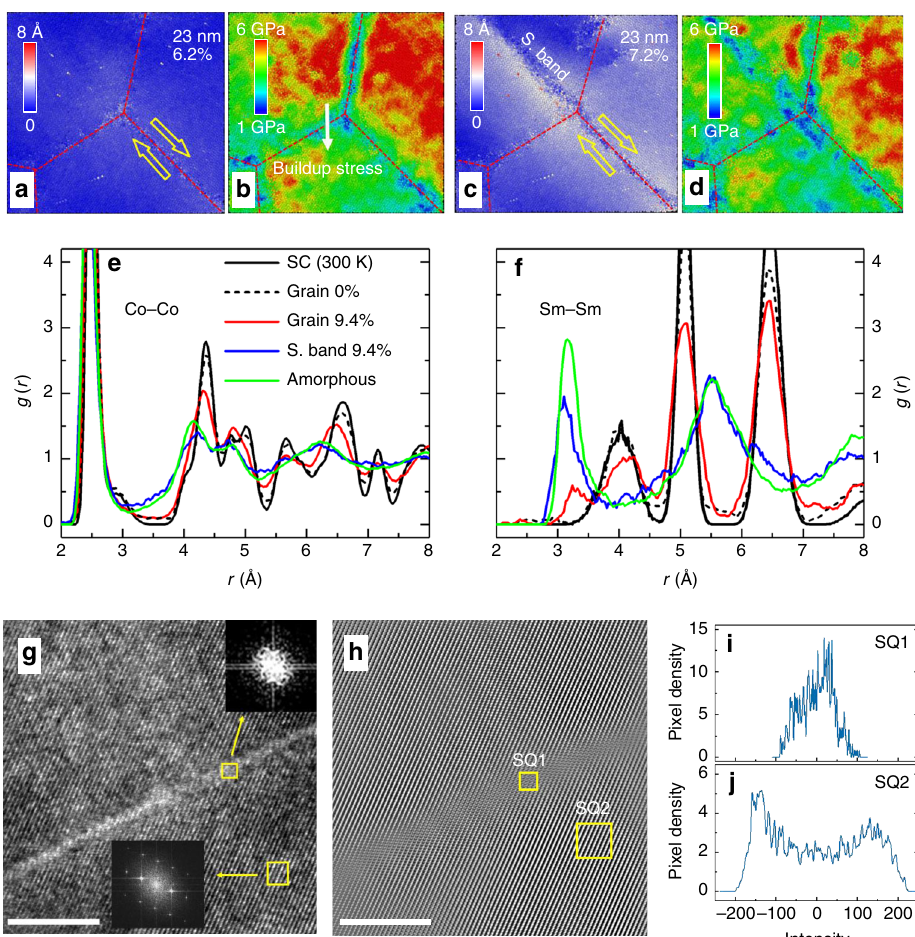
Fig. 3 Amorphous shear bands. a – d Displacements of atoms relative to their positions in the unstrained samples and distribution of von Mises stress in the same area around a triple junction for grain size of 23 nm under the strain of 6.2% ( a , b ), and the strain of 7.2% ( c , d ), respectively. e , f Pair distribution functions [ g (r)] of Sm – Sm ( e ) and Co – Co ( f ) for a bulk single crystal at 300 K (SC), unsheared crystalline region (Grain) in the grain with zero and 9.4% strain, shear band (S. band) under 9.4% strain, and the bulk amorphous state (quenched from 2000K). g The HRTEM image of a selected shear band and its surrounding regions. FFT patterns are shown in the insets. Scale bar, 10 nm. h – j The inverse FFT images: h shows a blurred stripe corresponding to the amorphous shear band. Scale bar, 10 nm. The pixel distribution of intensity is unimodal ( i ) and bimodal ( j ) for the shear band and surrounding regions, respectively, indicating amorphous and crystalline characters of these regions